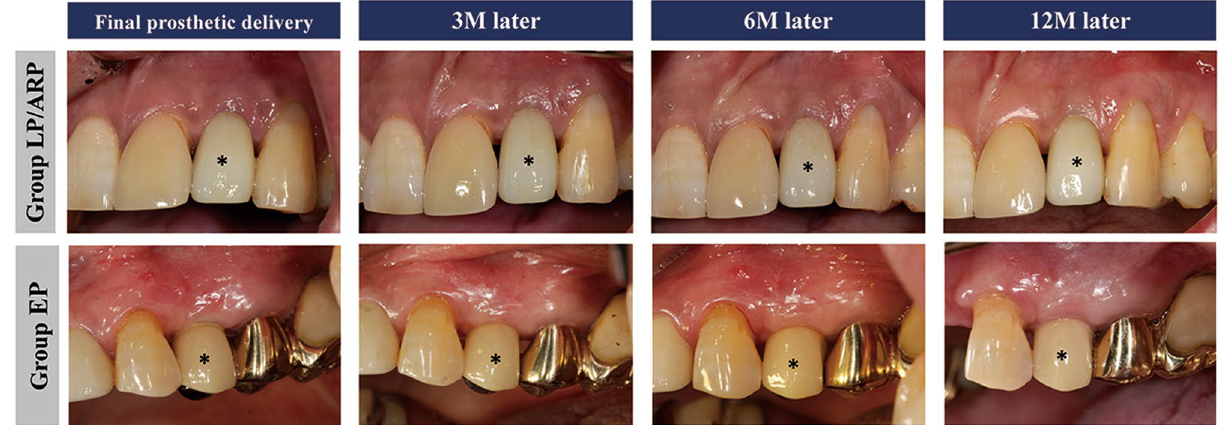
Figure 1. Clinical photographs over time. Asterisk indicates the implant crown included in the present